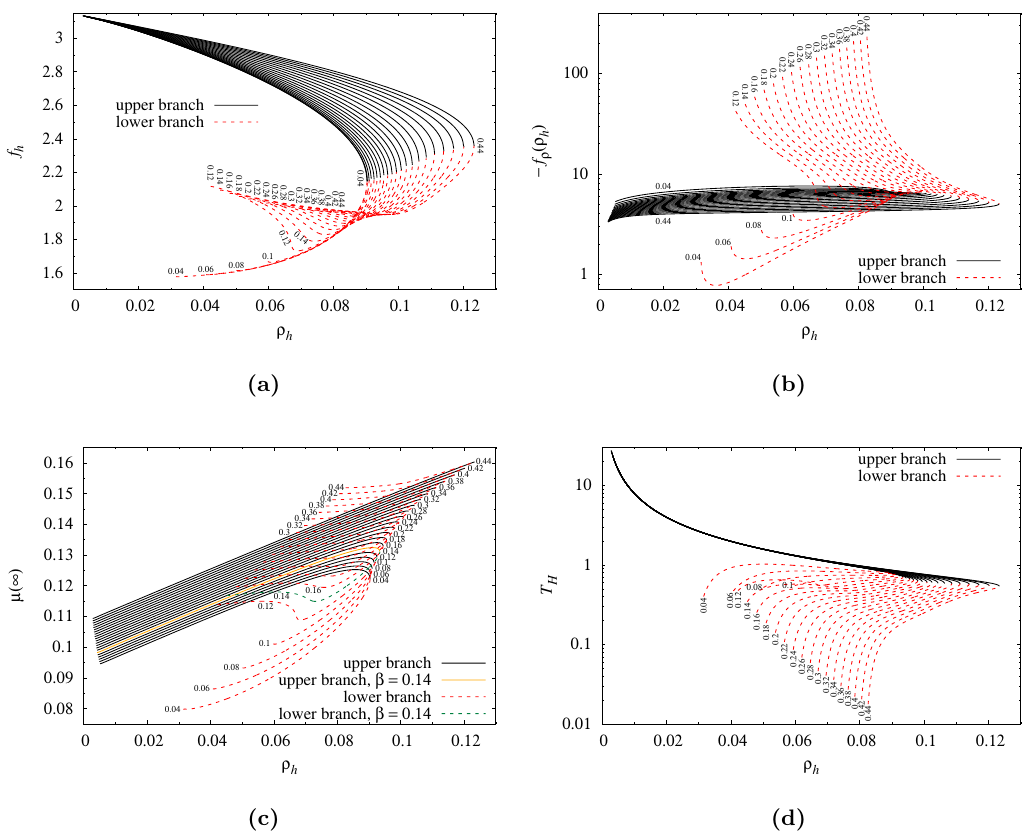
Figure 13 . Details of upper (black solid lines) and lower (red dashed lines) branches of solutions in the 2+4+12 model: (a) the value of the pro(cid:12)le function at the horizon, f h ; (b) the derivative of the pro(cid:12)le function at the horizon, f (cid:26) ( (cid:26) h ); (c) the ADM mass, (cid:22) ( 1 ); (d) the Hawking temperature T H , all as functions of the size of the black hole, i.e. the horizon radius, (cid:26) h . The numbers on the (cid:12)gures indicate the di(cid:11)erent values of (cid:12) = 0 : 04 ; 0 : 06 ; : : : ; 0 : 44. . 0 : 1, the upper branches do not have a bifurcation point at any (cid:12)nite (cid:12) and thus (cid:26) h